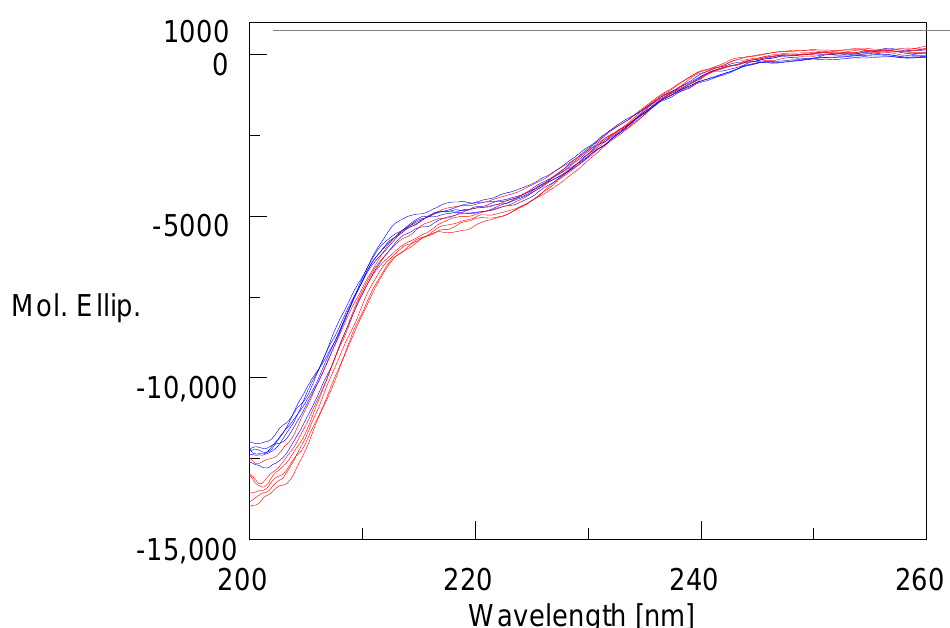
Figure 1. The CD spectra show the structures of synthetic glucagon and recombinant glucagon (new or aged lots) are equivalent. Three lots of AMP-glucagon at release and three lots at expiry (colored blue), three lots of recently manufactured and three lots of expired ELI-glucagon (colored red). Table 1. Secondary Structure Content of AMP-Glucagon and ELI-Glucagon by